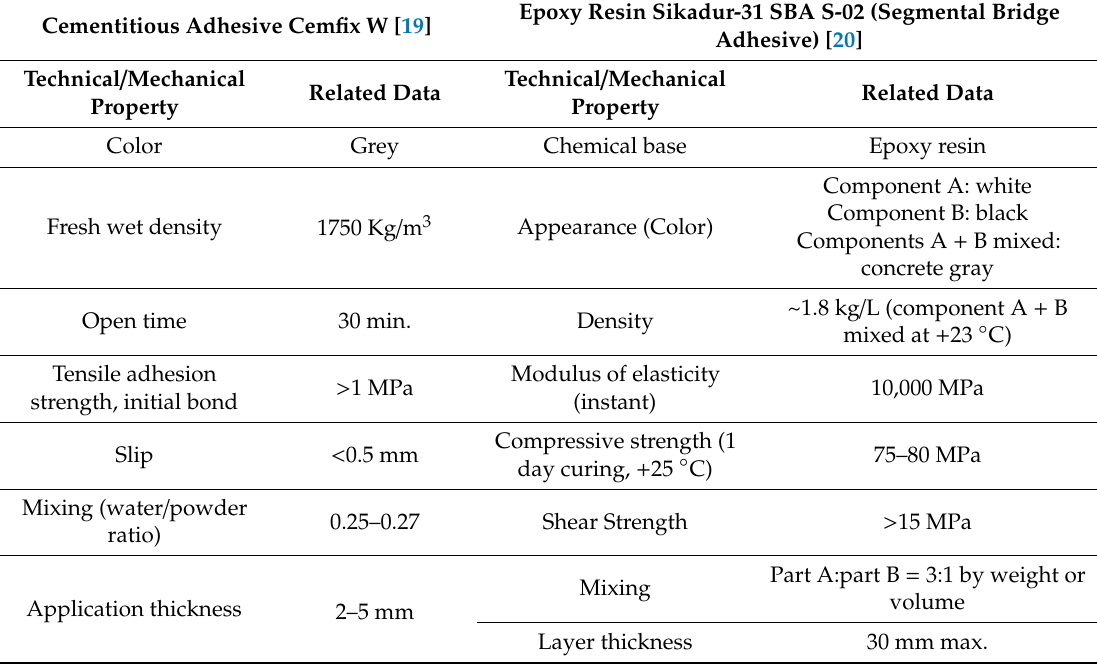
Table 4. Technical and mechanical properties of the used adhering materials in beams fabrications.